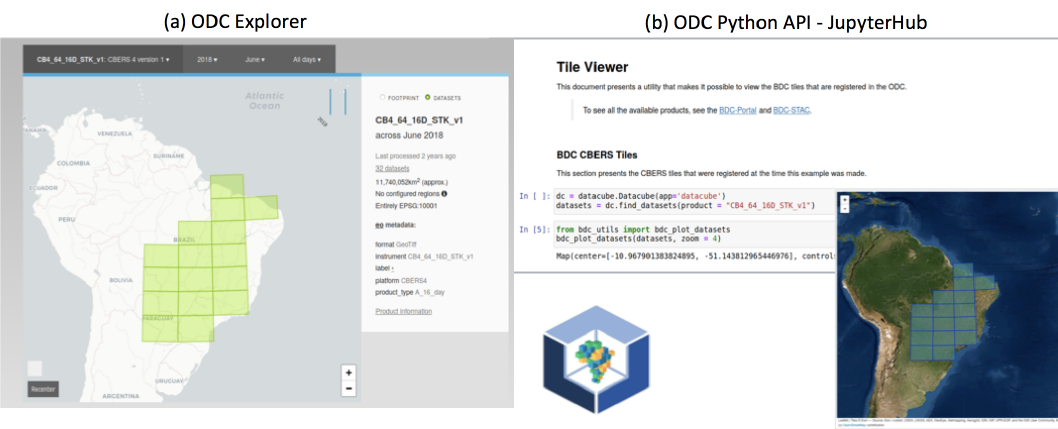
Figure 8. Accessing and processing CBERS-4 data cubes of the Brazilian Cerrado biome with the Open Data Cube framework: ( a ) ODC Explorer and ( b ) ODC Python API with